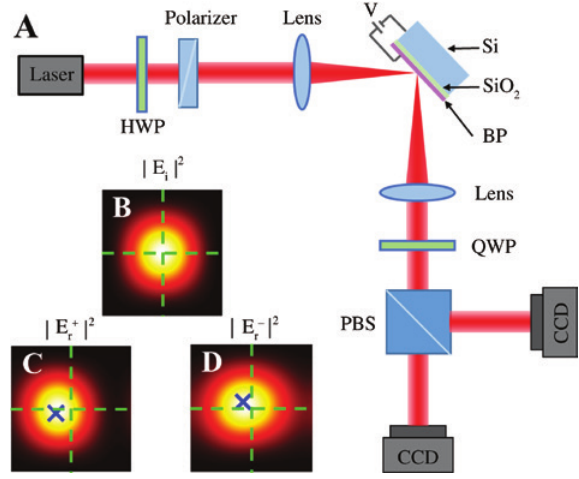
Figure 8: The possible experimental scheme and the intensity patterns of incident and reflected beams. (A) The possible experimental scheme for the asymmetric spin splitting in BP. (B–D) Intensity patterns of the Gaussian incident beam (B) and the RCP (C) and LCP (D) components of the reflected beam,